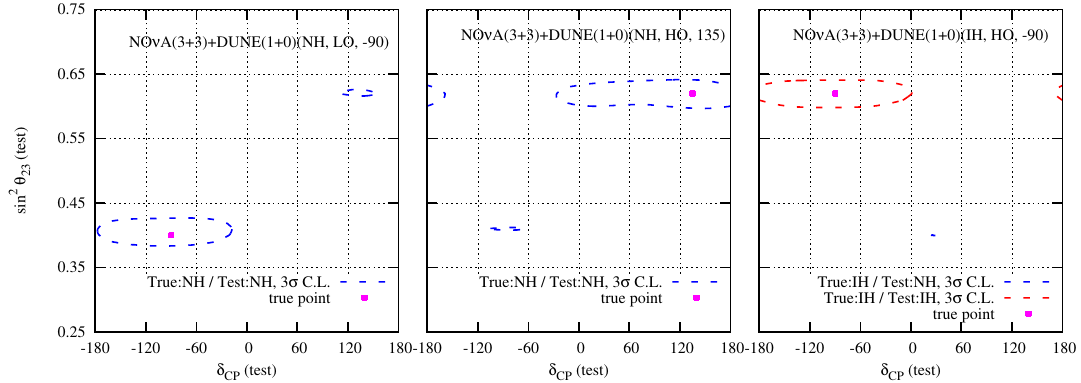
Figure 2 . Expected allowed regions in sin 2 (cid:18) 23 (cid:0) (cid:14) cp plane for a (3 (cid:23) + 3(cid:22) (cid:23) ) run of NO (cid:23) A plus a one year neutrino run of DUNE, assuming one of the three solutions in ref. [32] is the true solution. The left, middle and right panels represent (NH, LO, (cid:0) 90 (cid:14) ), (NH, HO, 135 (cid:14) ) and (IH, HO, (cid:0) 90 (cid:14) ) solutions respectively. The blue (red) curves are there for test NH